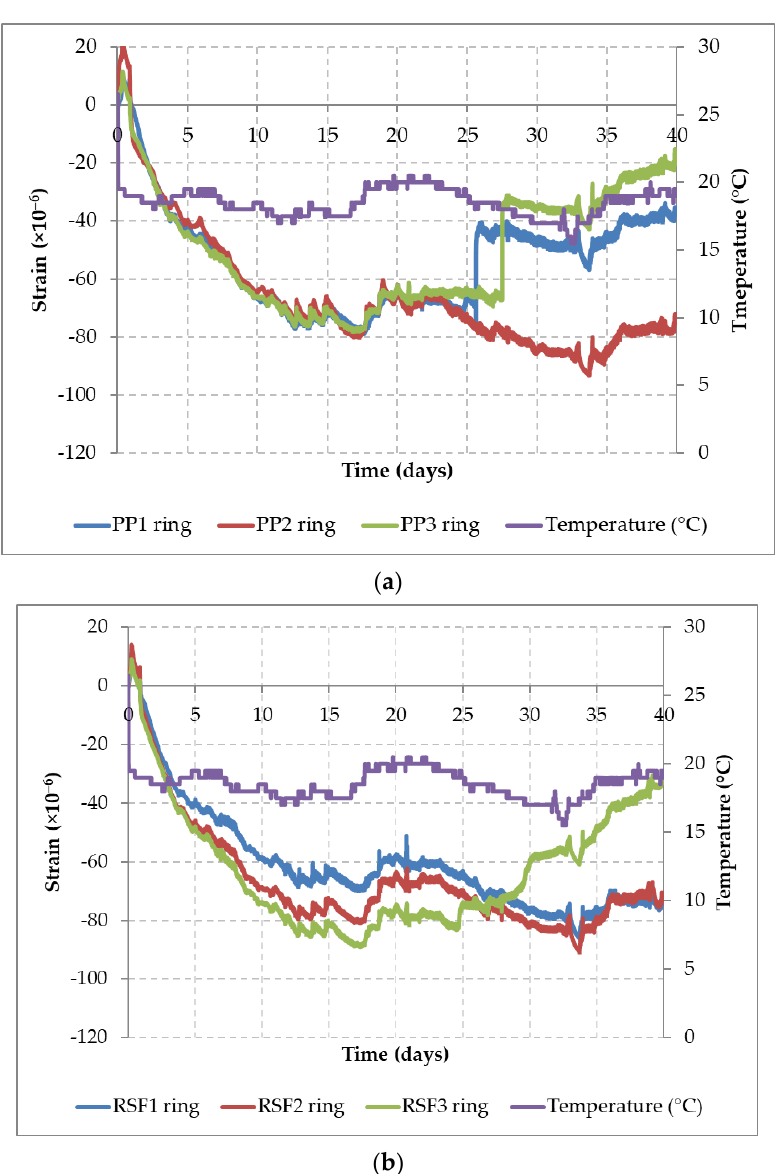
Figure 10. Inner ring strains recorded with the ASTM C1581 [57] test for cracking control evaluation: PPF-CC mix ( a ) and RSF-CC mix ( b ).